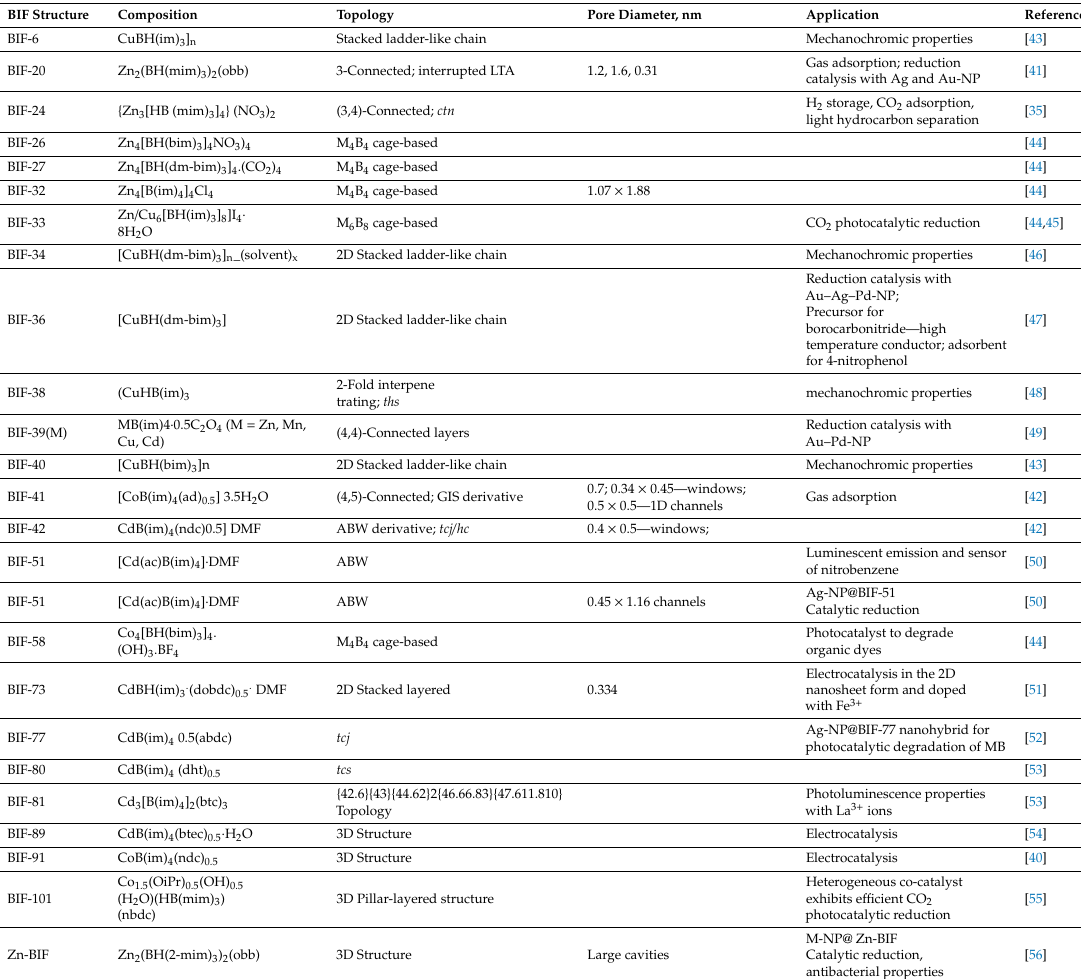
Table 1. Some practically relevant BIF